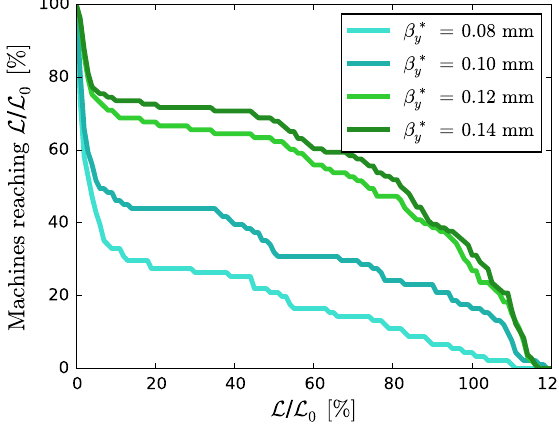
FIG. 9. Luminosity distribution after BBA and one scan of the linear knobs for different values of β (cid:1) y . 100 randomly misaligned machines are simulated, and the luminosity is normalized to the